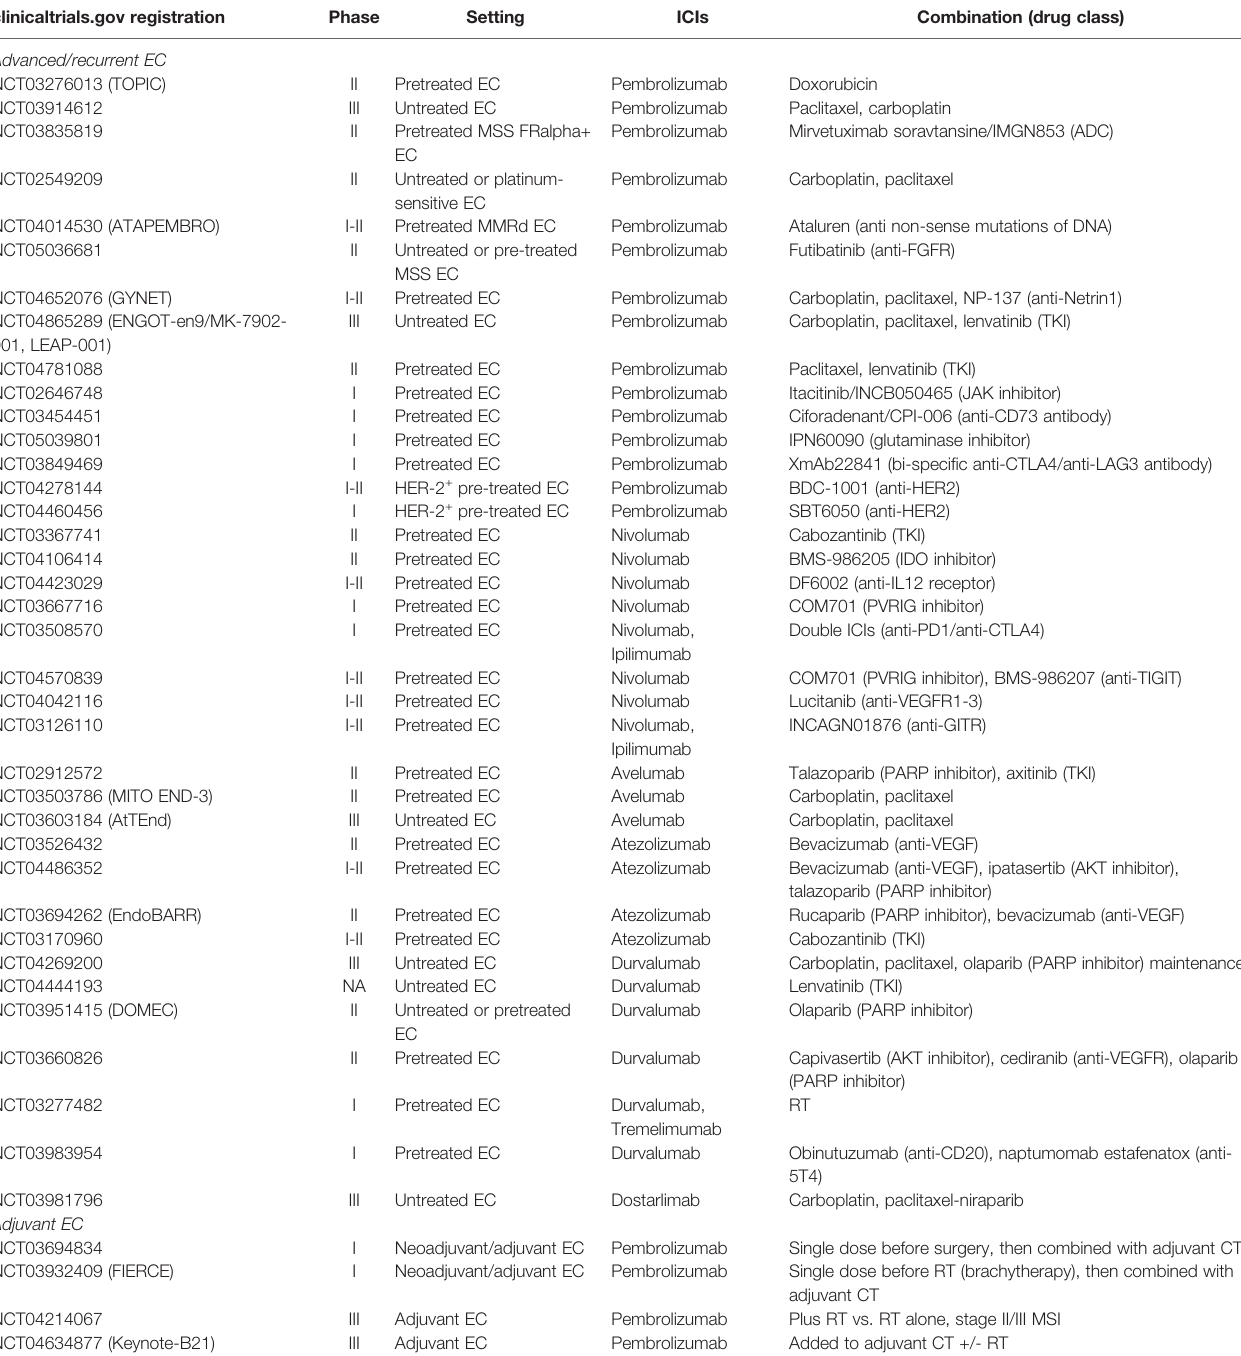
ADC, antibody – drug conjugate; AKT, AK strain transforming; CD, cluster of differentiation; CT, chemotherapy; FGFR, fi broblast growth factor receptor; FR, folate receptor; GITR, glucocorticoid-induced tumor necrosis factor receptor; HER-2, human epidermal growth factor receptor 2; IDO, indoleamine 2,3-dioxygenase; IL, interleukin; JAK, Janus kinase; LAG-3, lymphocyte-activation gene 3; MMRd, mismatch-repair de fi cient; MSS, microsatellite stable; NA, not applicable; PARP, poly(ADP-ribose) polymerase; PVRIG, poliovirus receptor-related immunoglobulindomain containing;RT, radiation therapy;TIGIT, T-cellimmunoreceptor with IgandITIM domains;TKI, tyrosine-kinaseinhibitor; VEGF, vascularendothelial growth factor; VEGFR,